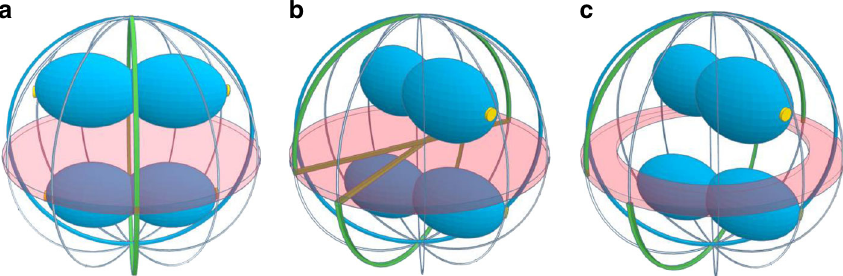
Fig. 3 New model for the geometry of cell division in S. aureus . Scheme of dividing S. aureus cells showing the scar of the previous division plane (blue ring), the current division plane (red disk) and the localization of the future division plane, where the divisome assembles (green ring). Chromosomes are shown in blue with origins of replication shown as small yellow discs. a The axis of chromosome segregation, which is parallel to the closing septum, establishes the division plane in S. aureus , as the origin proximal region is bound by the nucleoid occlusion effector Noc, which prevents FtsZ assembly. The only division plane that does not lead to bisection of the nucleoid is the plane indicated in green. b Chromosome segregation towards any of the meridians (grey lines) is geometrically equivalent. Therefore, chromosomes in sister cells can segregate in different orientations, releasing different planes for division (green lines). c Chromosome segregation can precede septum formation suggesting that positioning of the chromosomes, and not only of the septum, may prevent chromosome segregation towards